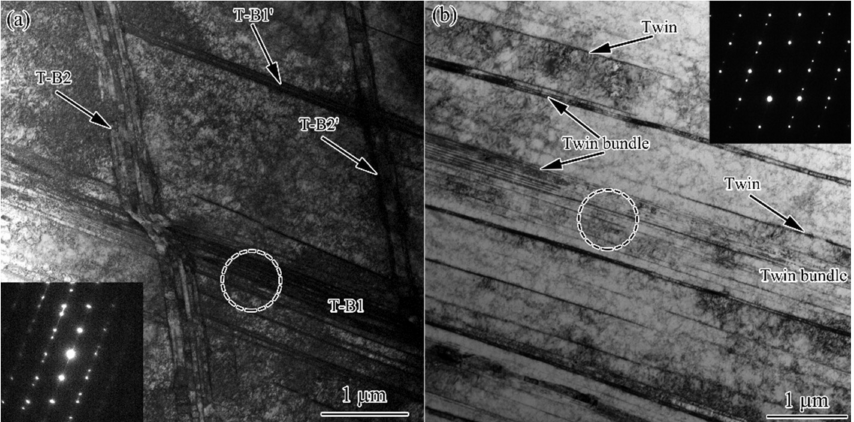
Figure 7. TEM observation of the intersection ( a ) and single ( b ) twin bundles for FTS in USRT AISI 304 stainless steel sample. Circles indicate the areas where the SAED patterns were